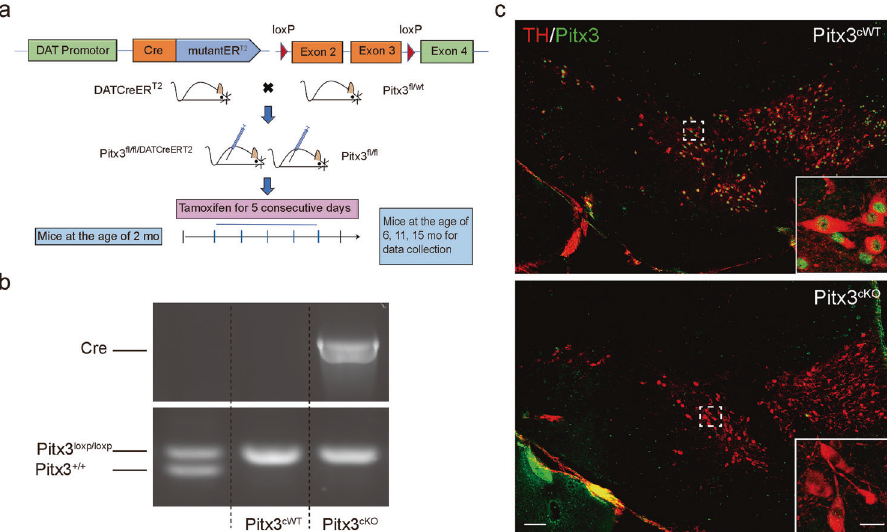
Fig. 1 Conditional knockout of Pitx3 in mdDA neurons. a The basic strategy for the generation of TAM-inducible Cre / loxp -directed Pitx3 knockout mice. An experimental timeline for the administration of TAM and tissue collection is also presented. b PCR detection of Cre transgene (upper) and Pitx3 fl oxed allele (lower). c IFC analysis for Pitx3 expression in mdDA neurons was performed using an antibody against Pitx3 (green) together with TH (red) in 4-month-old Pitx3 cWT and Pitx3 cKO mice (scale bar: 100 μ m; high-magni fi cation, 25 μ